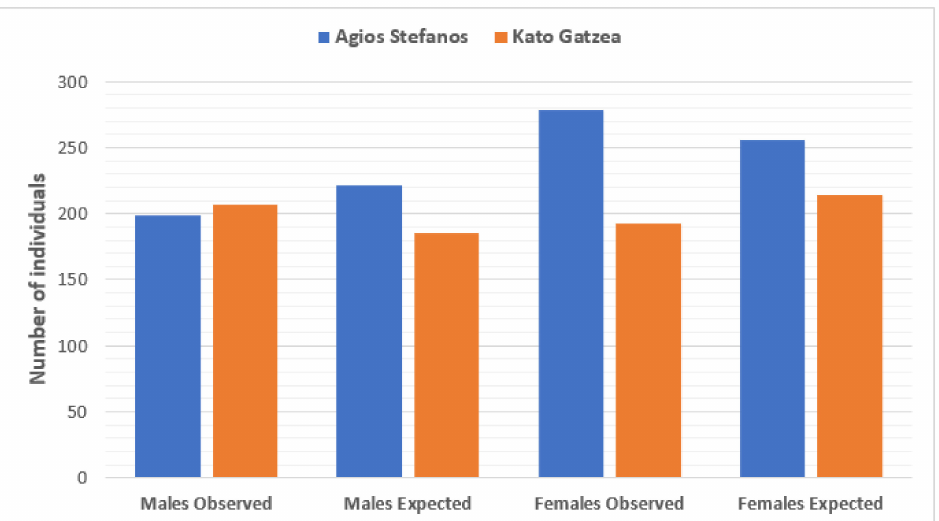
Figure 10. Results of chi-square test for association of observed and expected sex ratio between